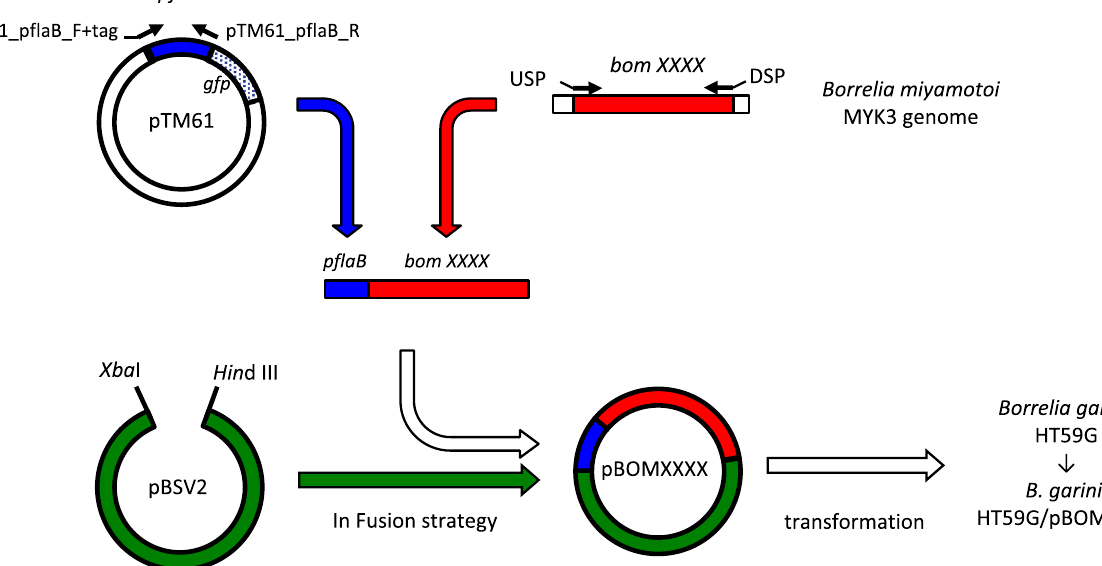
Figure 9. Schematic model of plasmid construction and transformation of recipient Borrelia. These were abbreviated in this figure as follows; promoter region of flaB gene ( pflaB ), upstream 5 ′ -DNA primer (USP), and downstream 3 ′ -DNA primer (DSP),